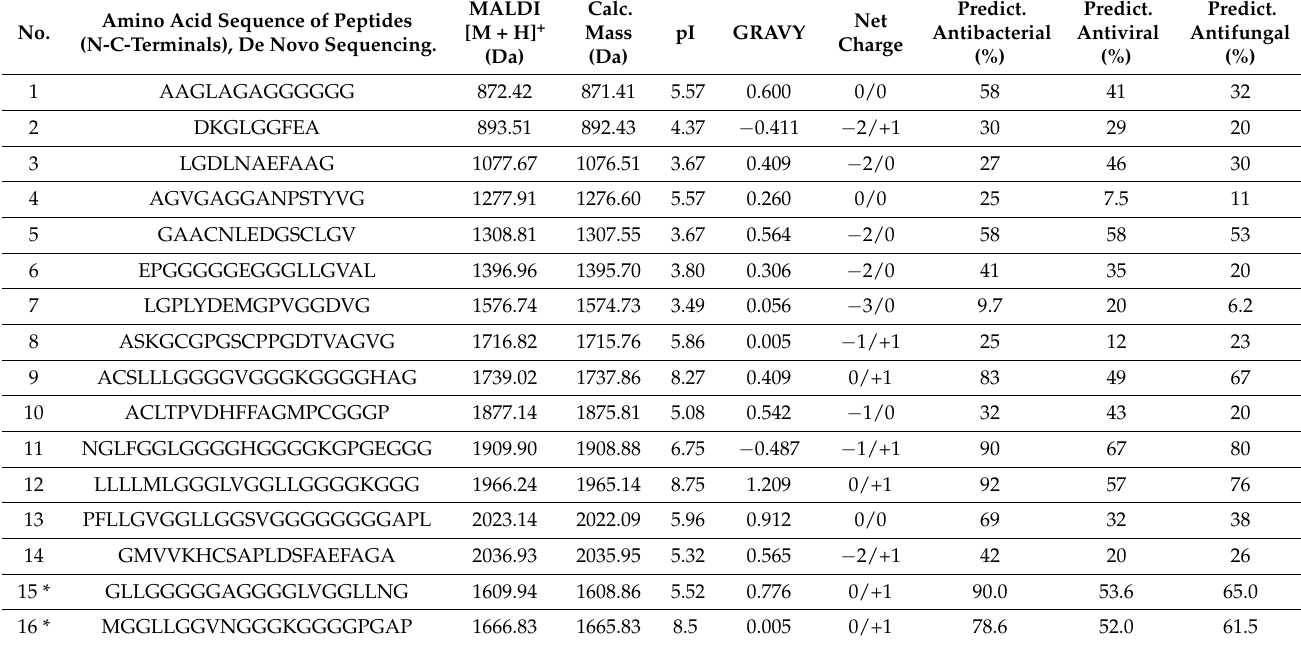
Table 1. The primary structures of the peptides presented in mucus fraction below 3 kDa, from the garden snail C. aspersum , identified by de novo sequencing in